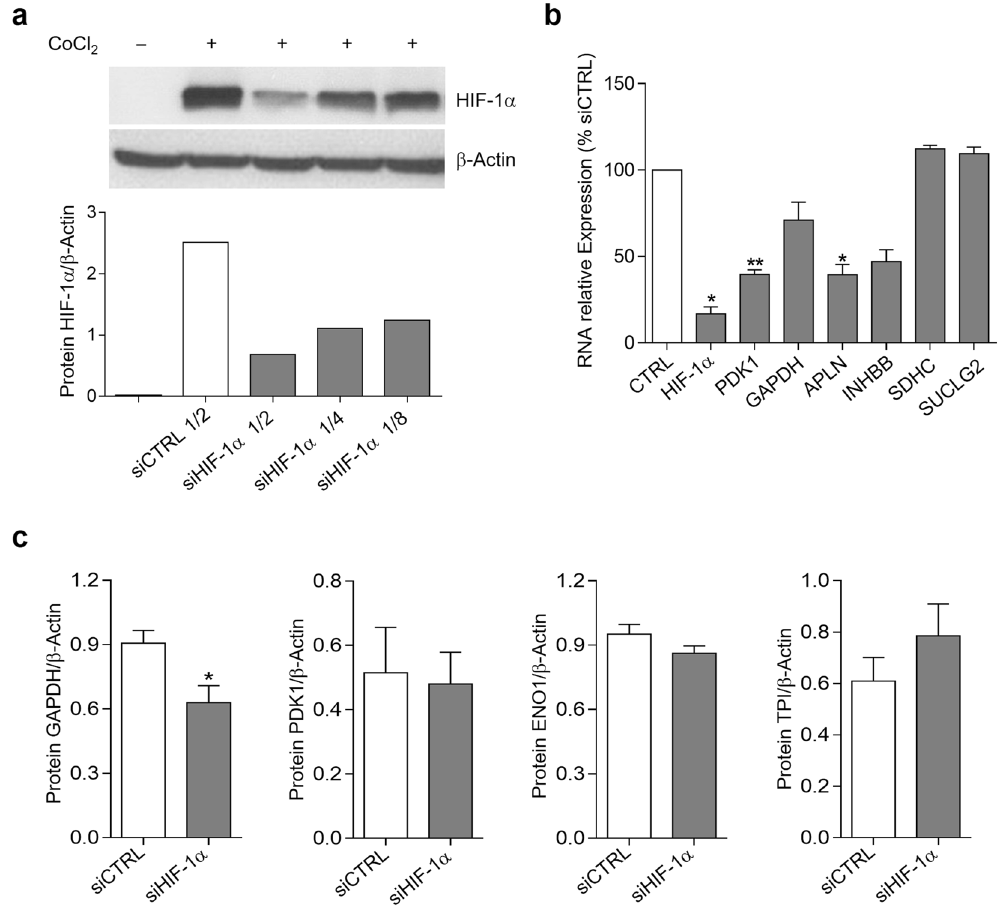
Figure 1. Evaluation of HIF-1 α function in SF under normoxic conditions. ( a ) Titration of HIF-1 α silencing in SF at 7 days after HIF-1 α or control (CTRL) siRNA lentiviral transduction after treatment with 300 μ M CoCl 2 . Western blot image of HIF-1 α and β -actin, and densitometric analysis of HIF-1 α expression normalized to the β -actin level. ( b ) Silencing efficiency of HIF-1 α siRNA lentivirus in normoxia by qRT-PCR (siCTRL mRNA gene/ β -actin ratio set to 100%). HIF-1 α , PDK1, GAPDH, INHBB, SDHC and SUCLG2 genes were analyzed. Data are mean ± SEM of 6 independent experiments ( * p = 0.03, ** p = 0.015, Wilcoxon Signed Rank test). ( c ) HIF-1 α knockdown down-regulates the expression of GAPDH. Protein expression of glycolytic enzymes GAPDH, PDK1, ENO1 and TPI under normoxic conditions measured by western blot in SF after lentiviral transduction with both HIF-1 α and non-silencing control (CTRL) siRNA. Protein extracts were obtained 4 days after transduction. Data are mean ± SEM of 7 independent experiments ( * p = 0.015, Wilcoxon